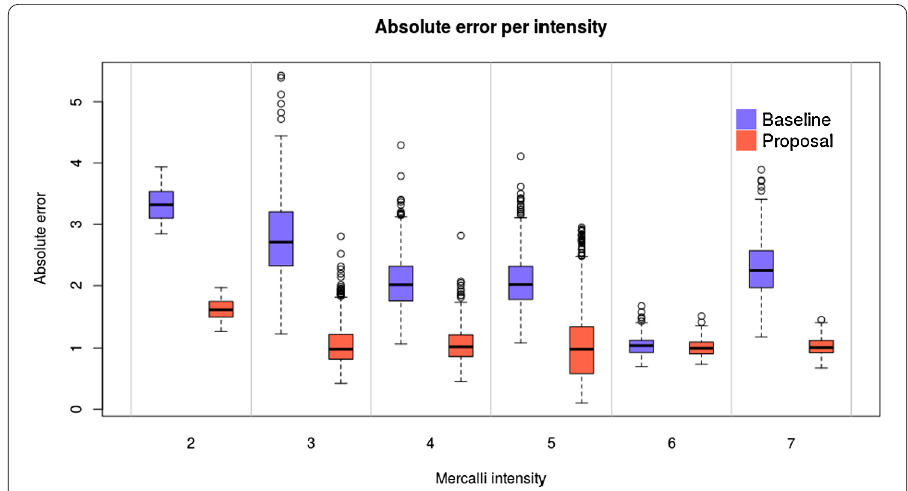
Figure 6 Differences in means of absolute errors between the proposed method and the baseline. Boxplots of absolute errors between the proposed method and the baseline. The figure shows boxplots stratified according to the maximum intensity of each earthquake